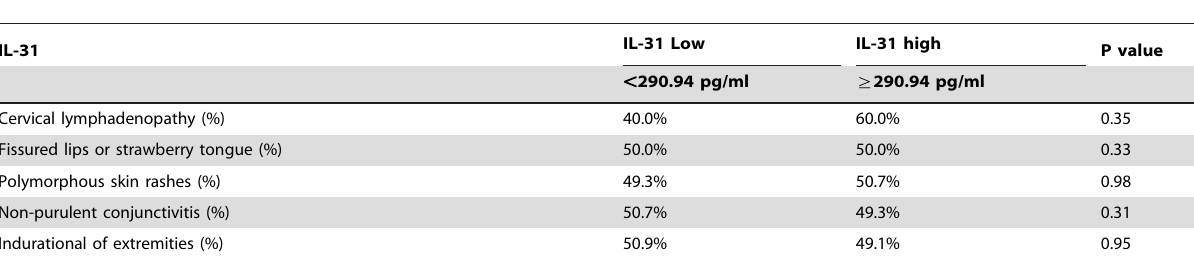
Table 2. Comparison of clinical symptoms in low vs. high plasma levels of IL-31.